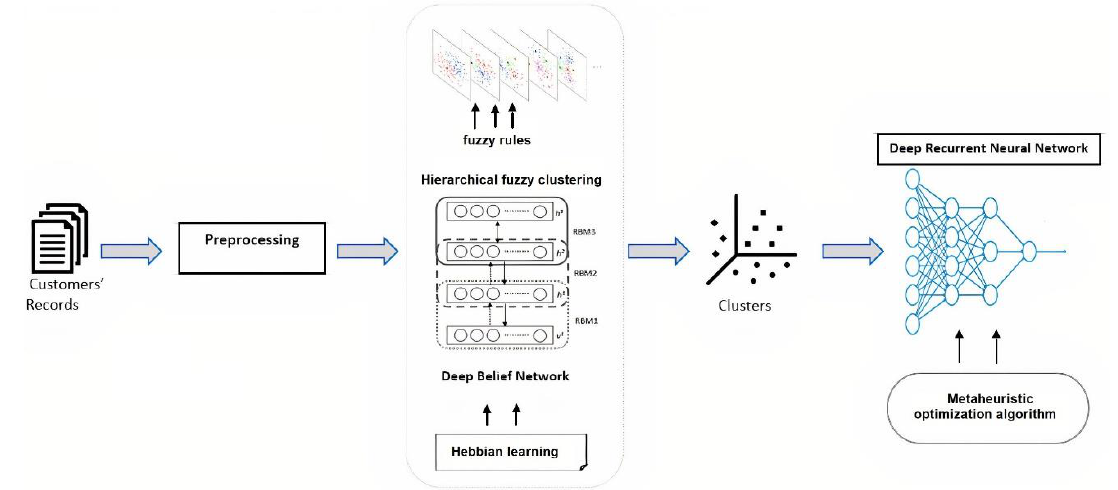
Figure 1. Overall structure of the prediction system.